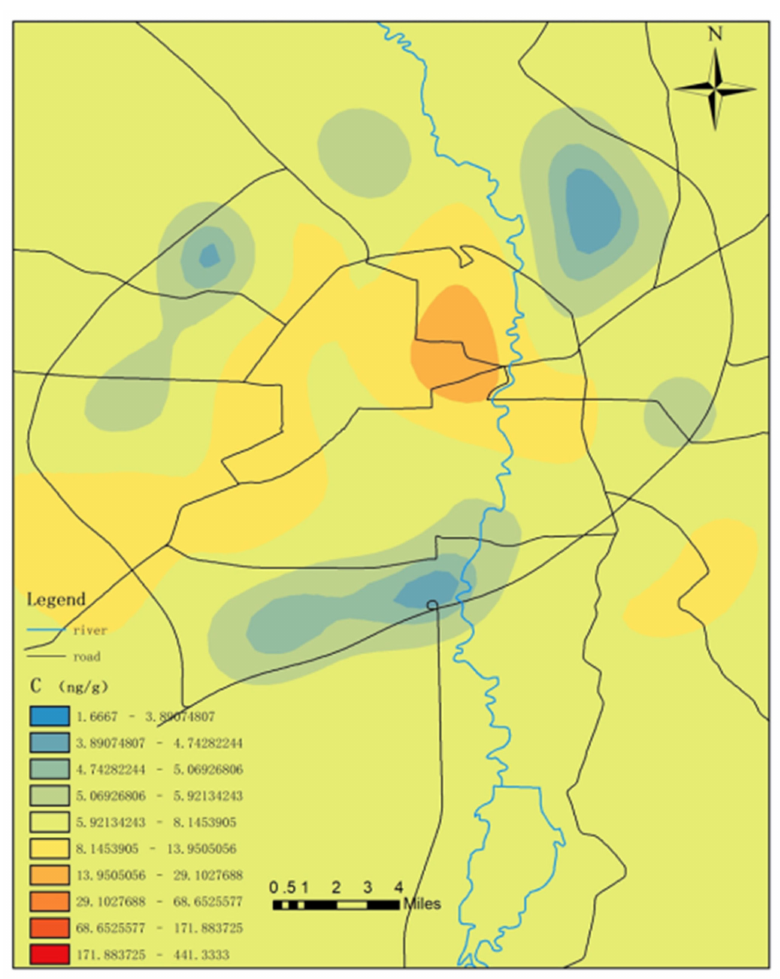
Figure 7. Distribution of surface mercury content at refuse collection